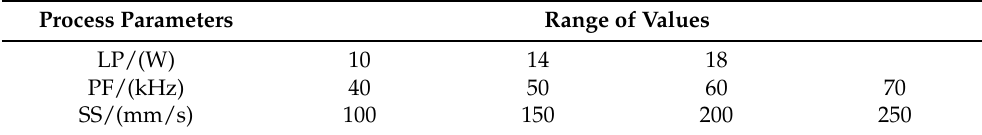
Figure 2. The laser pulse accumulation diagram of single-pass machining. Table 3. Process parameters of single-track scanning.